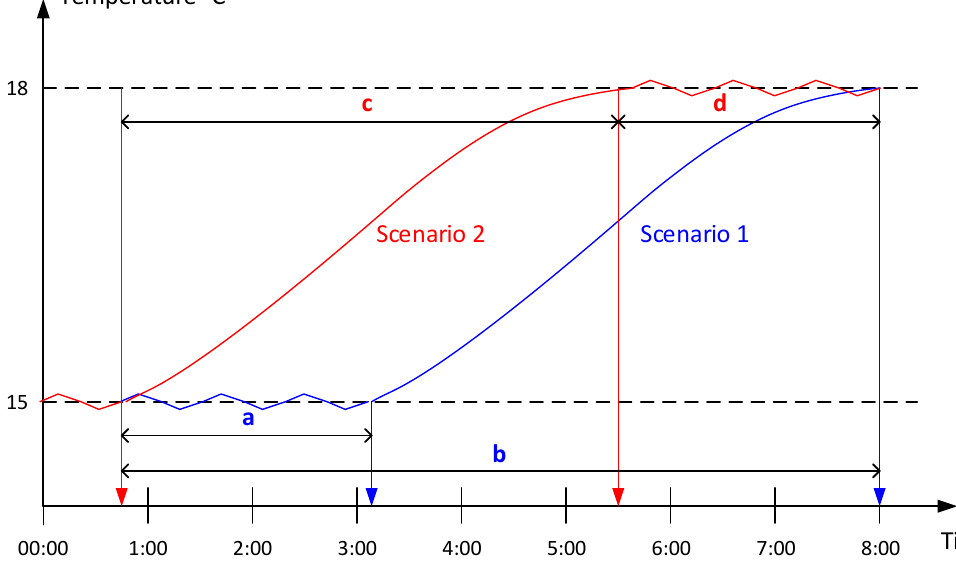
Figure 12. Heating the building using two different methods based on the energy